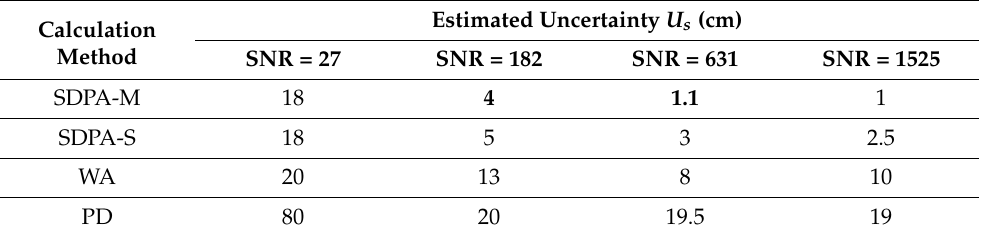
Figure 18. Total uncertainty U s of each presented algorithm estimated from all four trials. Table 5. Estimated uncertainty of each method calculated for different SNR conditions.